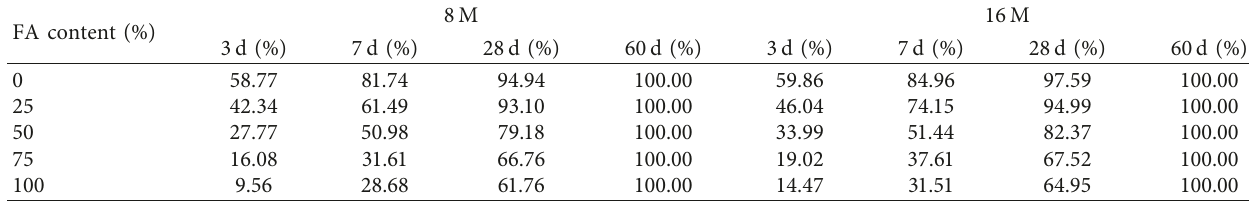
Table 4: Percentage increase in compressive strength at different time